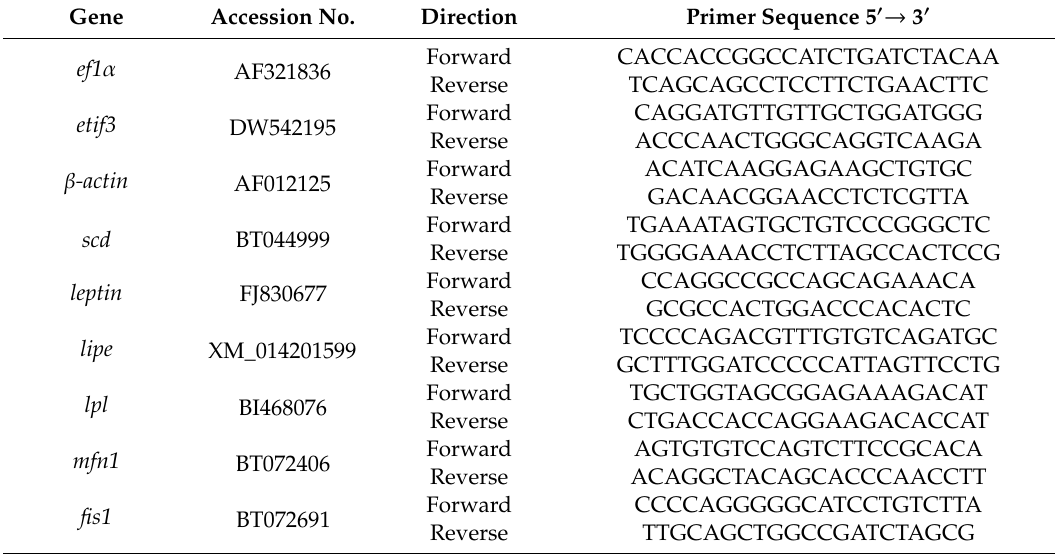
Table 3. Atlantic salmon primer sequences used for real-time